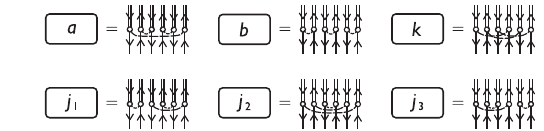
FIG. 17. The six local contractions for a block appearing in